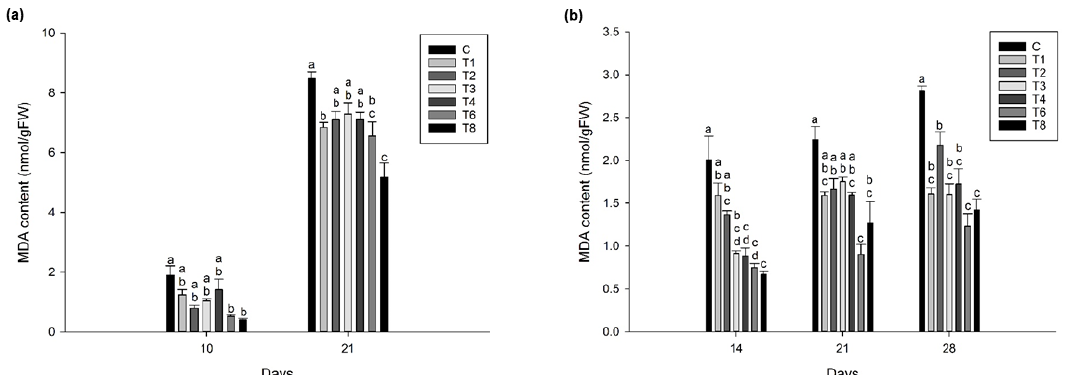
Figure 6. Effect of pretreatment of ANE and HA on the malondialdehyde (MDA) content in leaves of lettuce and spinach stored after harvest. ( a ) MDA content of leaves of lettuce stored at 0–4 °C in the dark with RH ≥ 95% for 10 and 21 days, treated with different concentrations of ANE, HA, and ANE + HA before harvest. ( b ) MDA content of leaves of spinach stored at 0–4 °C in the dark with RH ≥ 95% for 14, 21, and 28 days, treated with different concentrations of ANE, HA, and ANE + HA before harvest. Different combinations of ANE and HA used for preharvest treatment were as follows: C (control), T1 (0.1% ANE), T2 (0.25% ANE), T3 (0.2% HA), T4 (0.4% HA), T6 (0.1% ANE + 0.4% HA), and T8 (0.25% ANE + 0.2% HA). Each experiment was performed in triplicate, and each experimental unit had six plants. The average of the eighteen values were presented as mean ± SE and means represented by same letters were not significantly different at p ≤ 0.05.